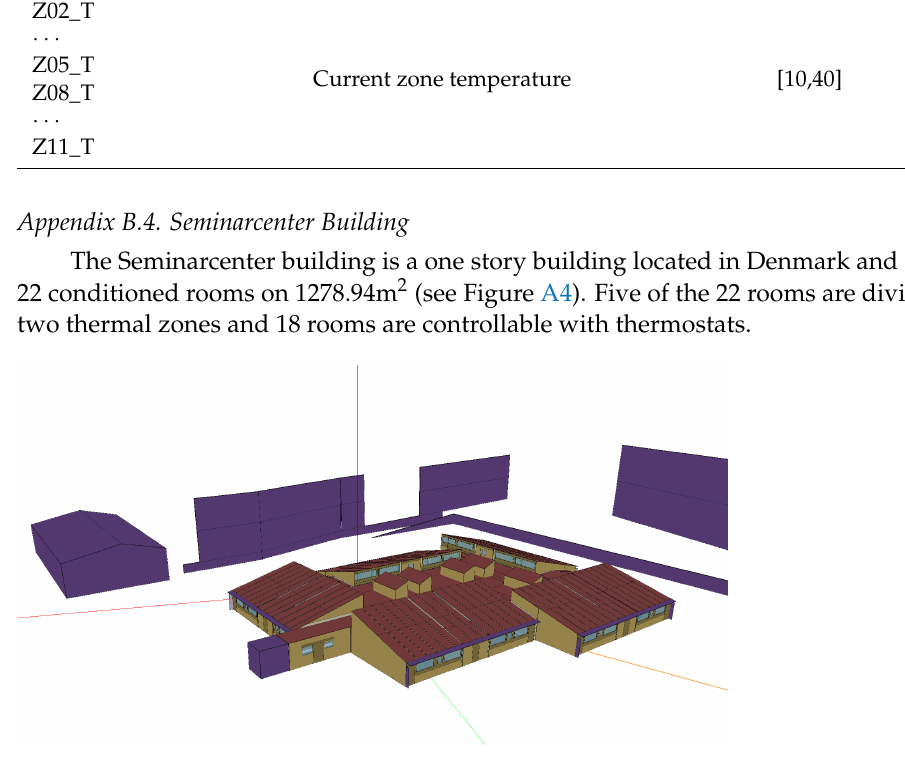
Figure A4. Envelope of the Seminarcenter